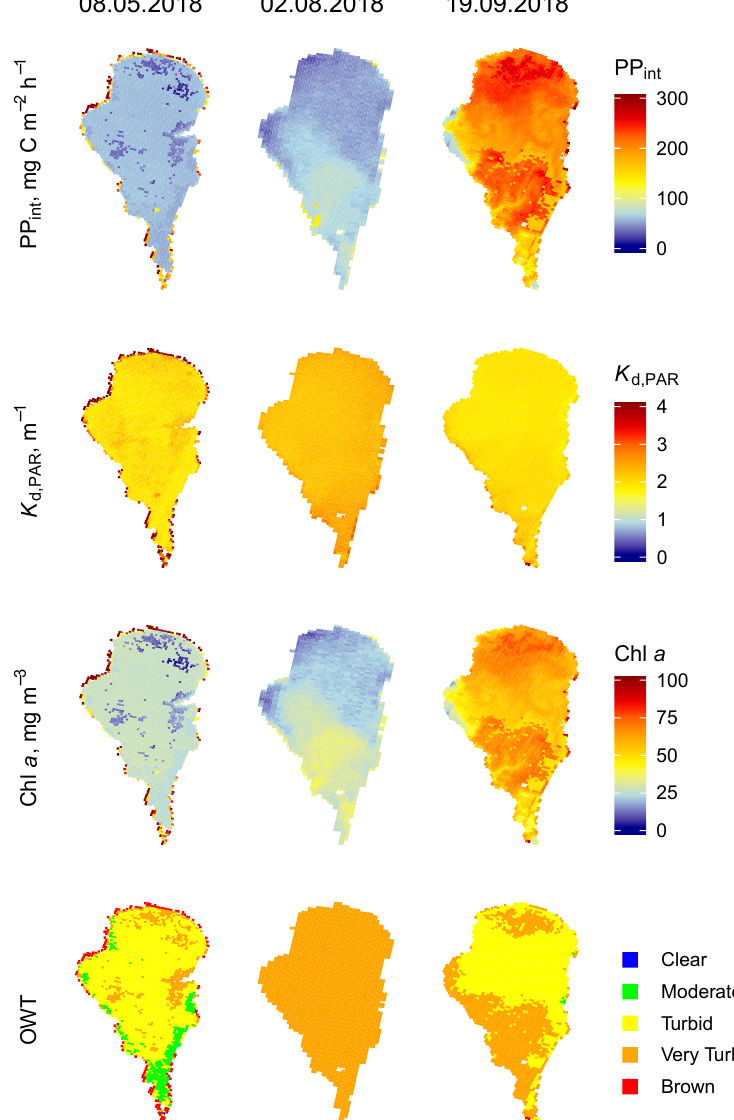
Figure 4. Three examples of the modelled integral primary production (PP int , mg C m − 2 h − 1 ) (first row), attenuation coe ffi cient in the photosynthetically active region ( K d,PAR , m − 1 ) (second row), chlorophyll- a (Chl a , mg m − 3 ) (third row), and optical water type (OWT) (fourth row) of Lake V õ rtsjärv derived from Ocean and Land Color Instrument (OLCI)